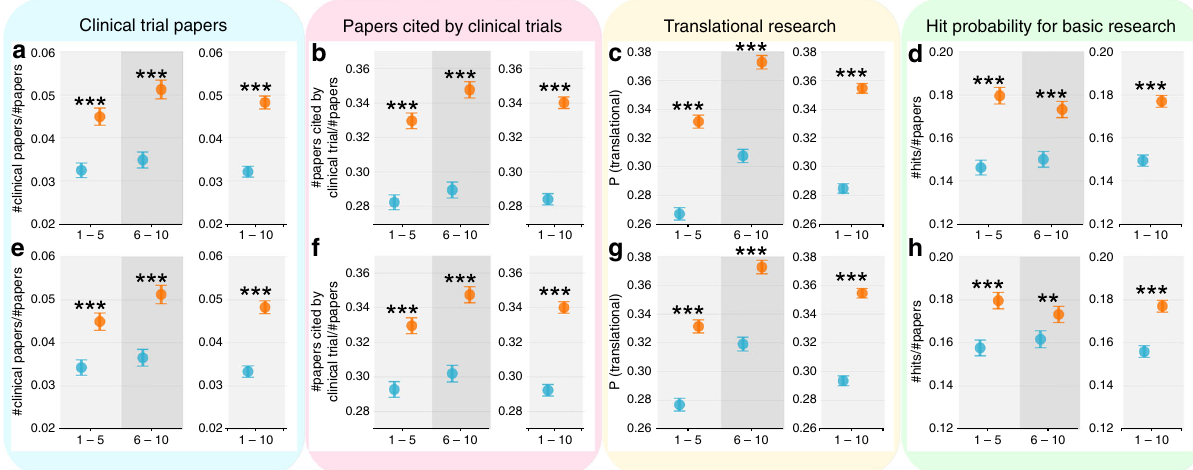
Fig. 4 Near misses (orange) outperformed narrow wins (blue) in both basic and translational science. Here, we considered three measures probing the clinical relevance of their research: (1) clinical trial papers in the PubMed dataset (direct contribution to clinical translation); (2) papers cited by at least one clinical trial paper (indirect contribution to clinical translation); (3) papers with potential to become translational research. Speci fi cally, the approximate potential to translate (APT) score was used to identify early signatures of bench-to-bedside translation. The score is estimated using machine learning combining features such as MeSH terms, disease, therapies, chemical/drug, and citation rates. a Near misses outperformed narrow wins in terms of the probability of producing clinical trial papers in the next 1 – 5 years, and 6 – 10 years; b The same as a but for papers cited by clinical trials in the future; c The same as a but for papers with potential to be a translational research; d Hit paper probability by considering non-clinical trial papers only. e – h The same as a – d but for the conservative removal (following the same procedure in Fig. 3b). *** p < 0.001, ** p < 0.05, * p < 0.1; Error bars represent the standard error